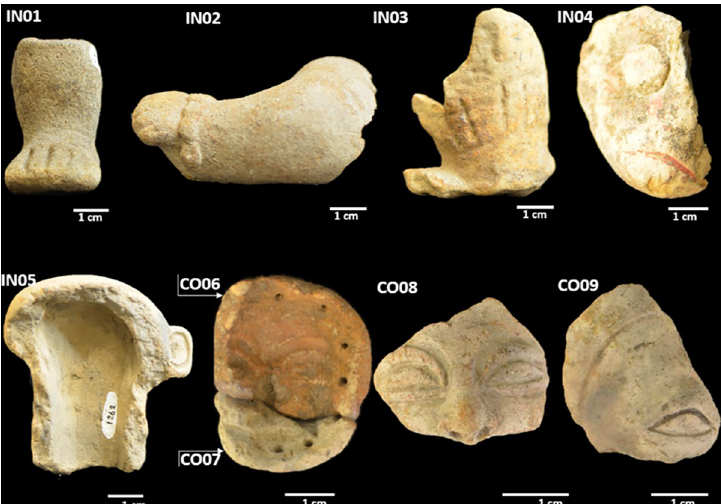
Fig 2. Figurine fragments selected for study. From left to right assigned identification/original identification IN01/ FR-A0034 T1 Z16 5; IN02/FR-A0034 T1 Z16 16; IN03/FR-A0034 T1 Z16 14; IN04/FR-A0034 1261; IN05/FR-A0034 1262; CO06/R SUP 87 (dark area); CO07/R SUP 87 (bright area); CO08/Cocotera Tr4 20–30 cm and CO09/Coc. Sub. Tr4 50–60